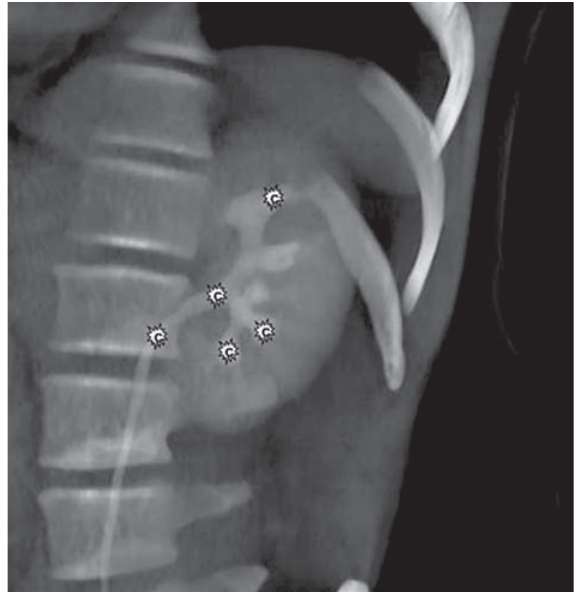
Figure 1 – Three-dimensional volume rendered oblique coronal reformatted image with 10% gray demonstrating the accessibility of stone bearing locations when the intercostal approach is used for percutaneous removal of calculi from the posterior superior calyx, pelvis, posterior and anterior inferior calyx, ureter and of staghorn calculi. c =